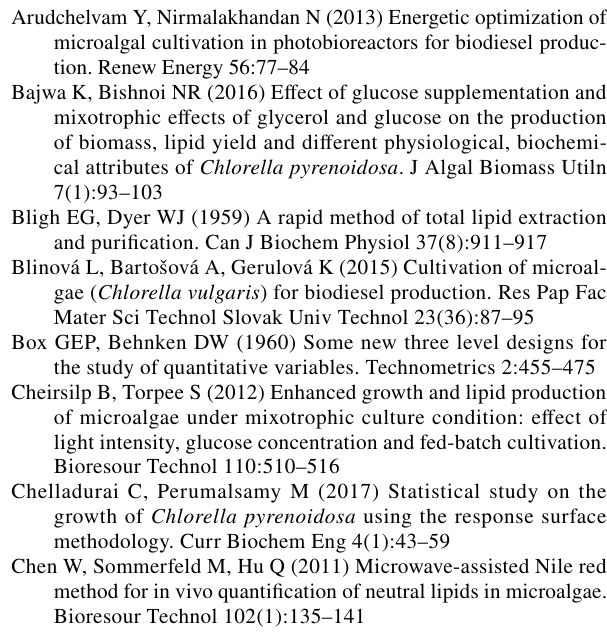
Relative percentage of free acids detected by GCMS SFA Saturated fatty acids, MUFA monounsaturated fatty acids, PUFA polyunsaturated fatty